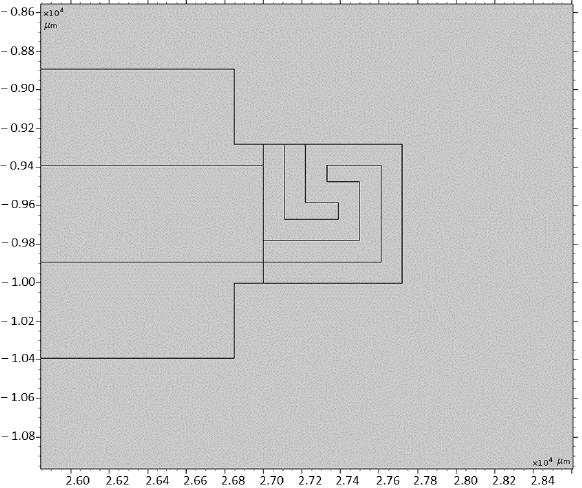
Figure 1. Microheater Model (720 × 720 µ m 2